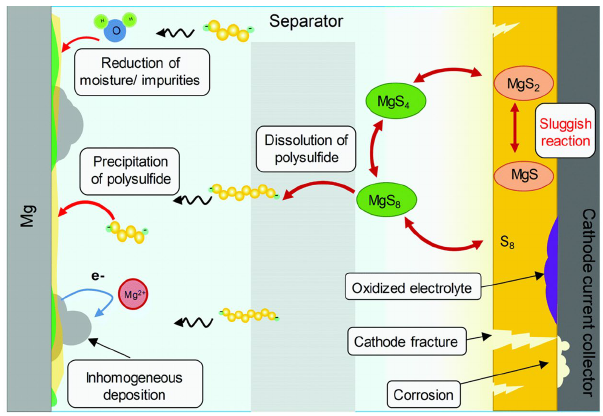
Figure 5. The general failure mechanism for Mg − S batteries [28]